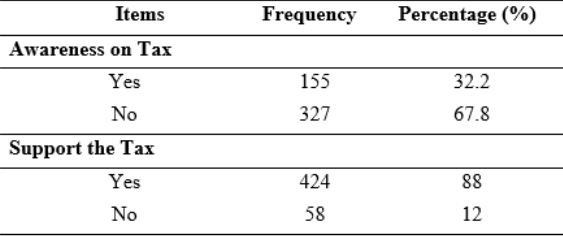
The respondents indicated their awareness on tax payments for the upkeep of the city shows in Table (5). Majority (67.8%) was unaware of the tax, but almost all respondents (88%) agreed to pay tax and contribute money to keep the city clean. Similarly, Desa at el [22] stated that Malaysia uses 40% to 70% of its taxes on waste management. Table 5: Respondents’ awareness of tax and contribution for SWM